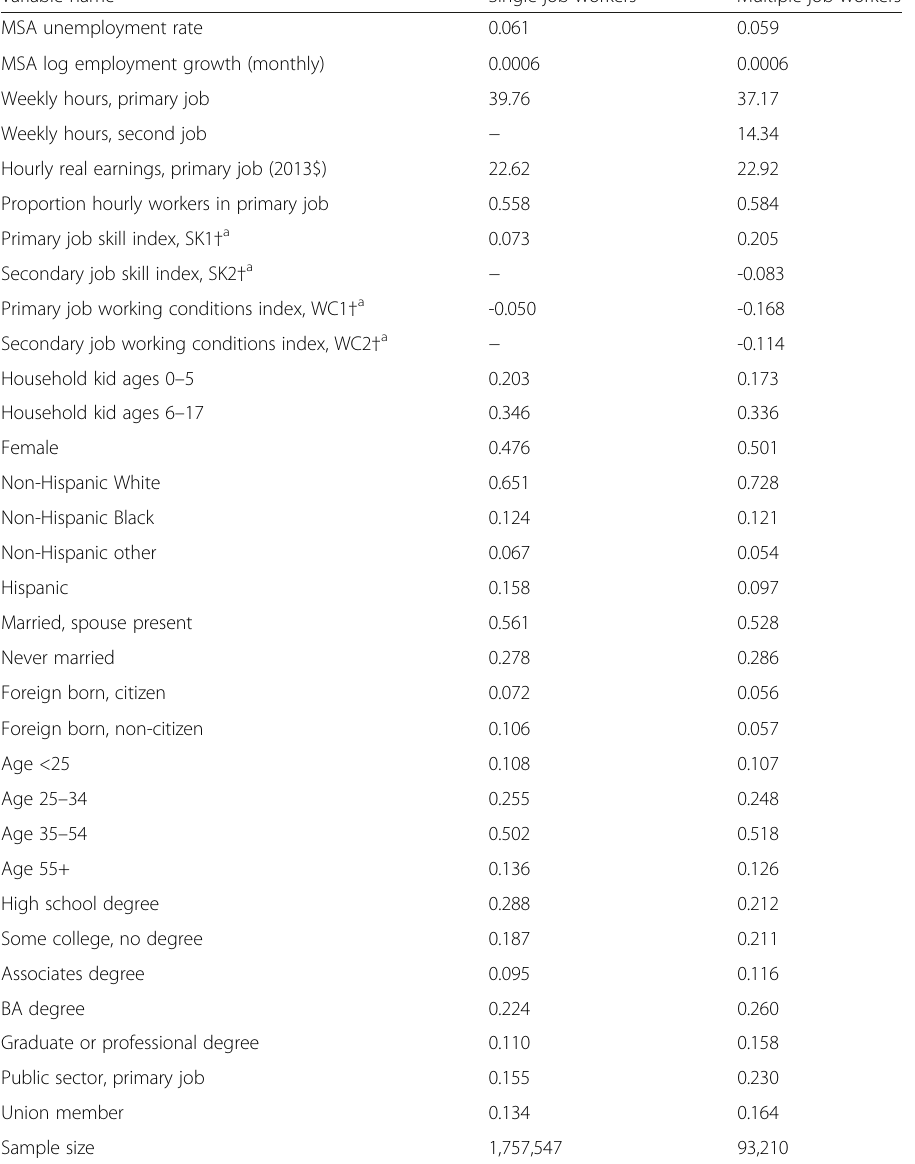
Table 1 Means for single and multiple job workers, selected variables Variable